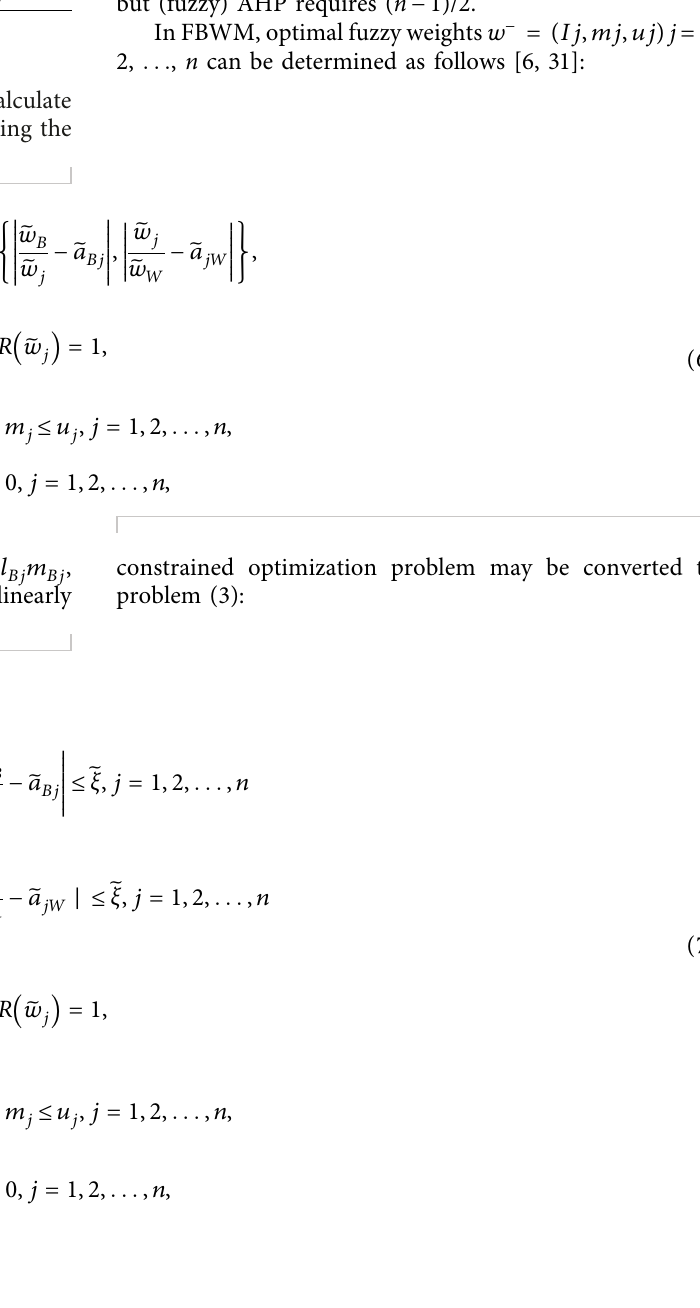
linguistic words in Table 1, each DM calculates the priority of all other criteria over the worst criterion, which is then translated to TFNs 􏽥􏽥 a jw j � ( 1 , 2 , . . . , n ) . It is worth noting that 􏽥􏽥 a BB �( . 1 , 1 , 1 )